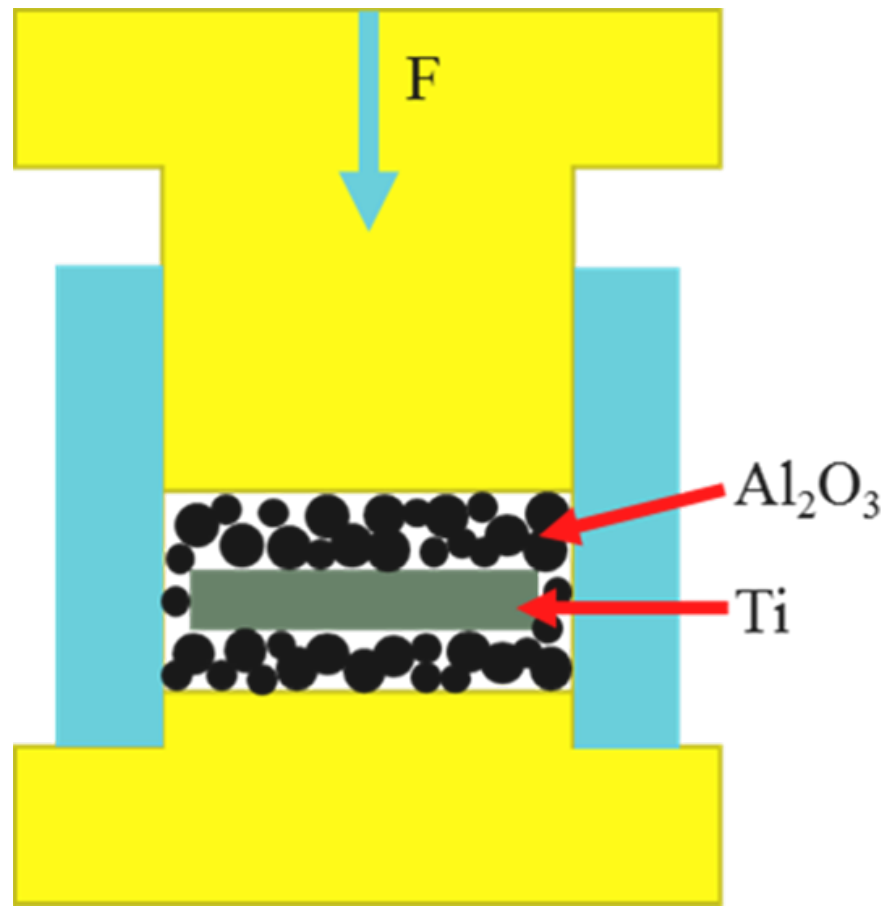
Figure 1. Schematic diagram of Ti/Al 2 O 3 composite prepared by the powder stacking method.